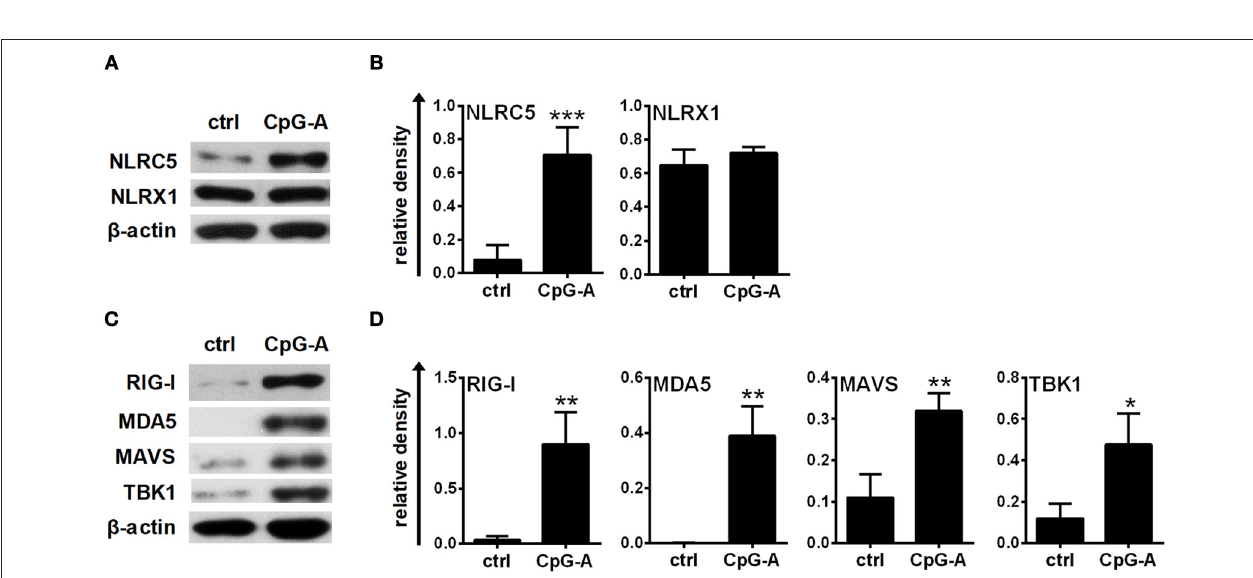
FIGURE 2 | The expression of NLRC5, RIG-I, and MDA5 is inducible in primary human pDCs after CpG-A treatments. (A–D) Freshly isolated primary human pDCs were stimulated with 2.5 µ M CpG-A for 16h, thereafter the protein levels of NLRC5, NLRX1, RIG-I, MDA5, MAVS, and TBK1 were detected by western blotting. Representative blots are shown in (A,C) . Data are shown as mean ± SD from 3 to 4 experiments in panels (B,D) . (B,D) Statistical comparisons were performed using Student’s t -test. * p < 0.05, ** p < 0.01, *** p <